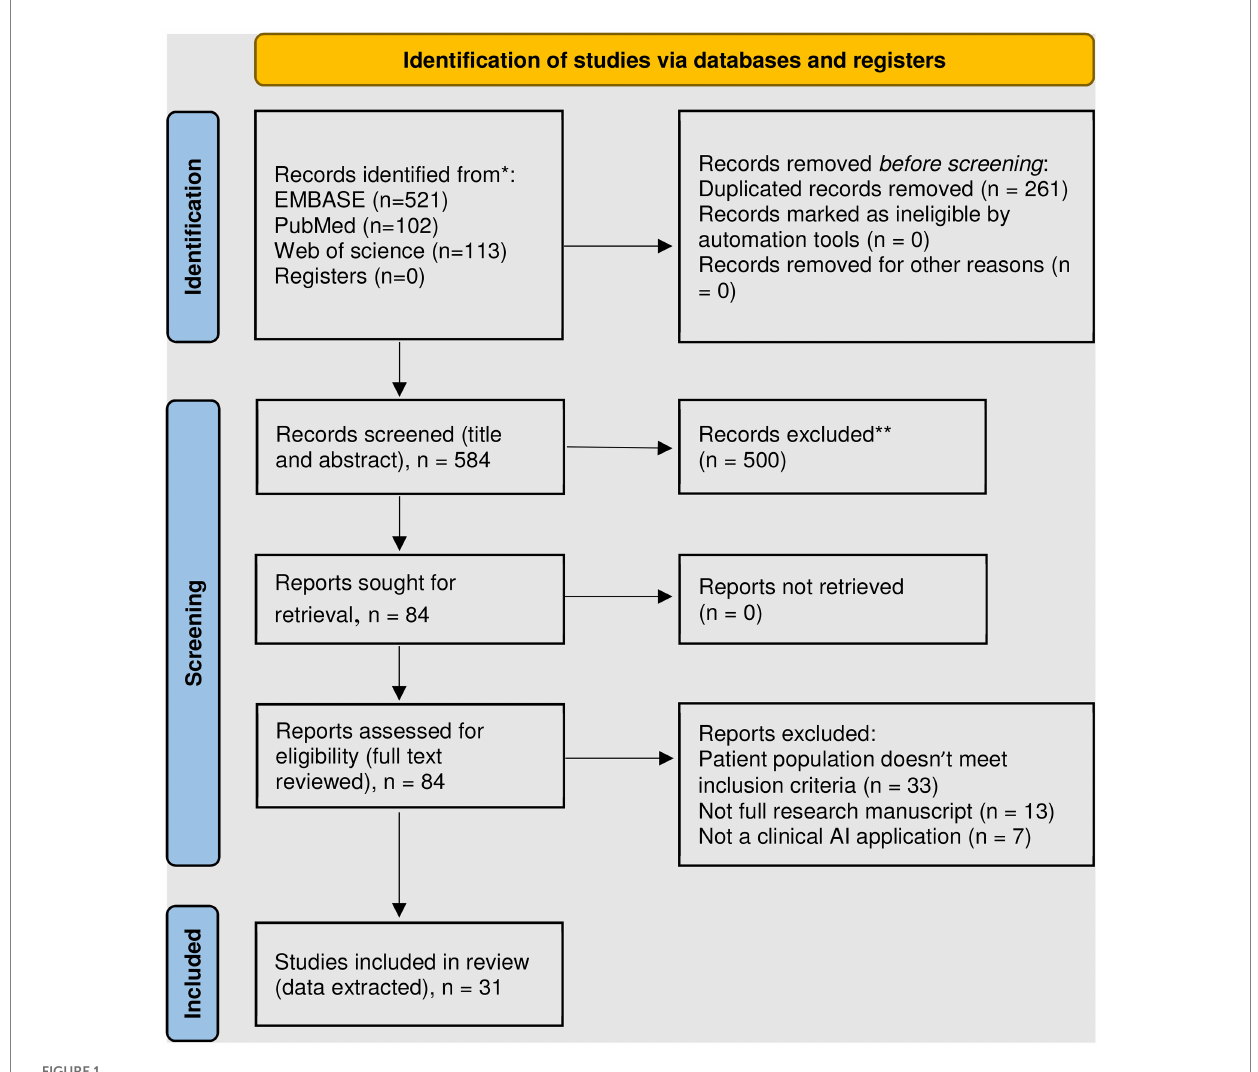
FIGURE 1 PRISMA 2020 flow diagram for new systematic reviews which included searches of databases and registers only (4). *Consider, if feasible to do so, reporting the number of records identified from each database or register searched (rather than the total number across all databases). **Exclusion criteria included: review articles, meta-analyzes, conference abstracts, non-English language, animal and ex-vivo studies, non-AI methods, and those whose primary outcome is in the phase of care prior to transplantation or mechanical circulatory